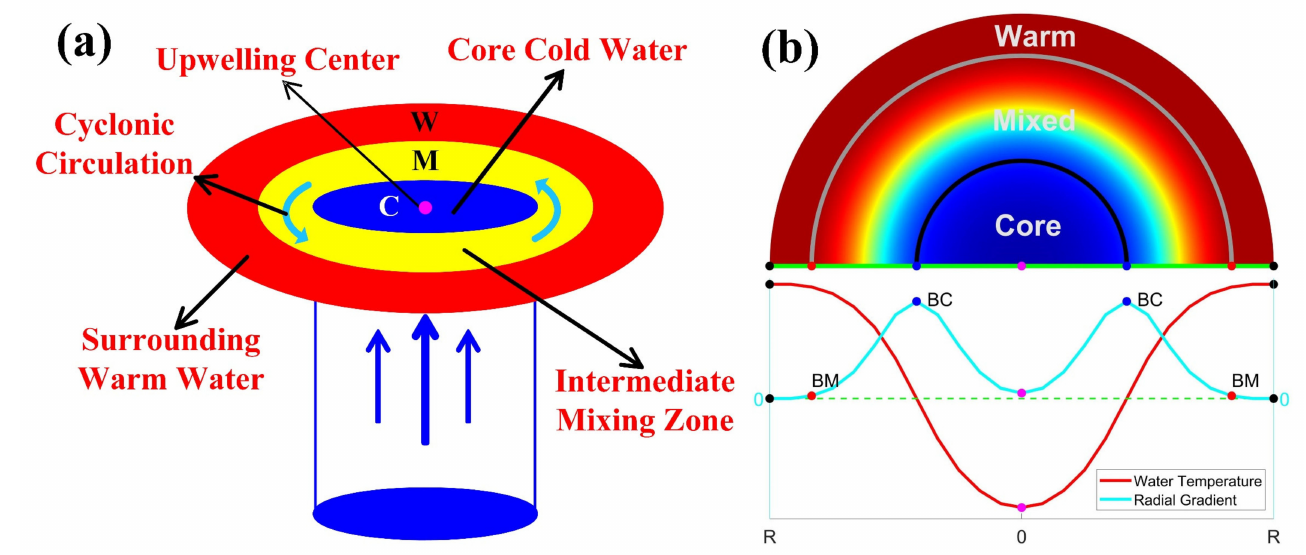
Figure 2. ( a ) Schematic of the pointwise upwelling’s spatial structure; ( b ) radial distribution of SST and its gradient within the pointwise upwelling, adapted with permission from Ref. [11]. 2019, Wenbin Yin and Daji Huang.